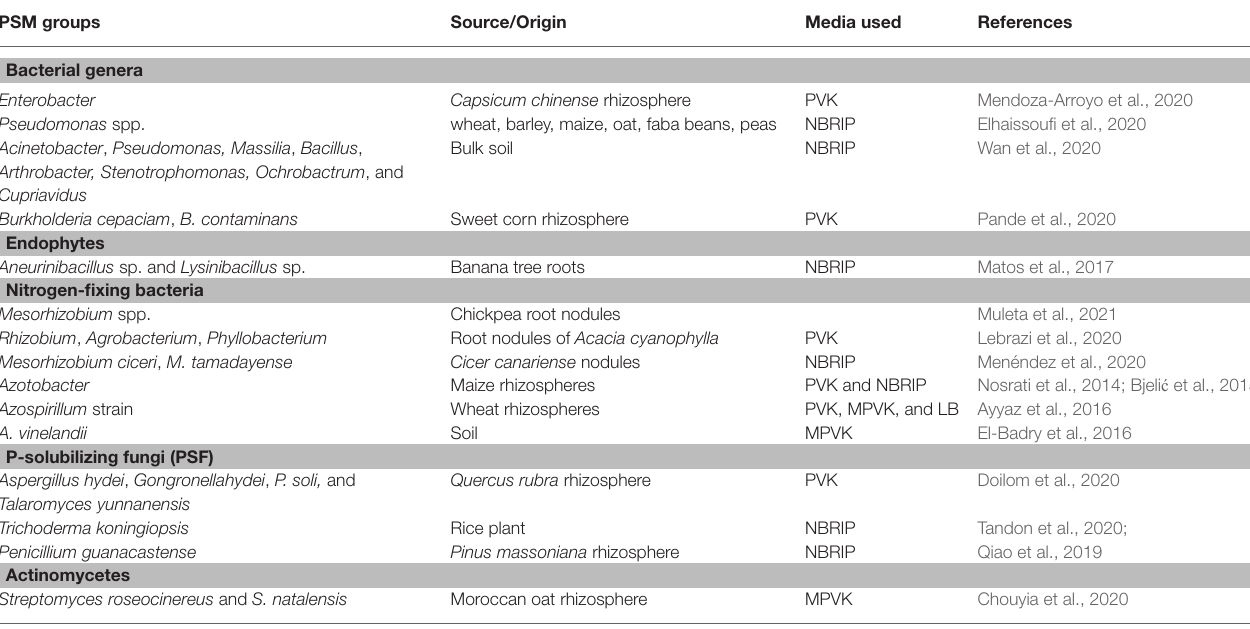
TABLE 1 | Phosphate solubilizing microbiome biodiversity in different agroecological